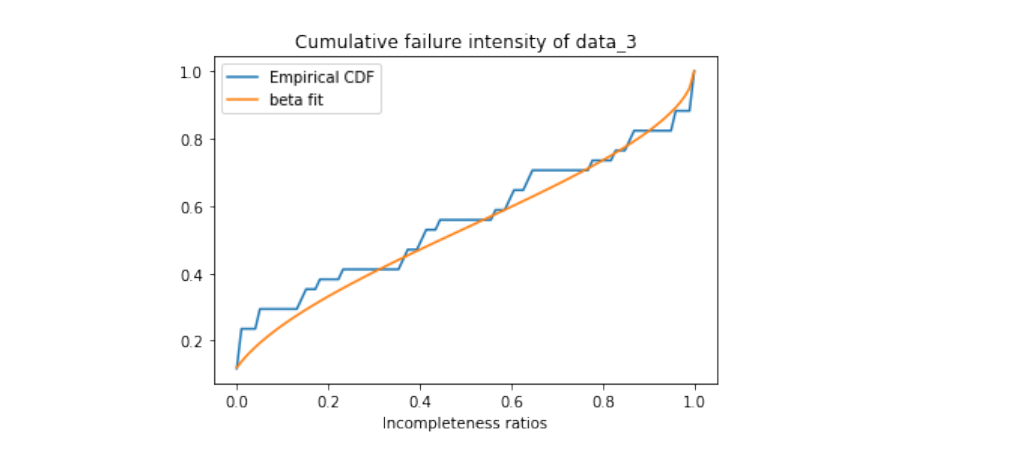
Figure 12. Empirical CDF on the fitted beta distribution on Provisional Counts of Death Dataset.